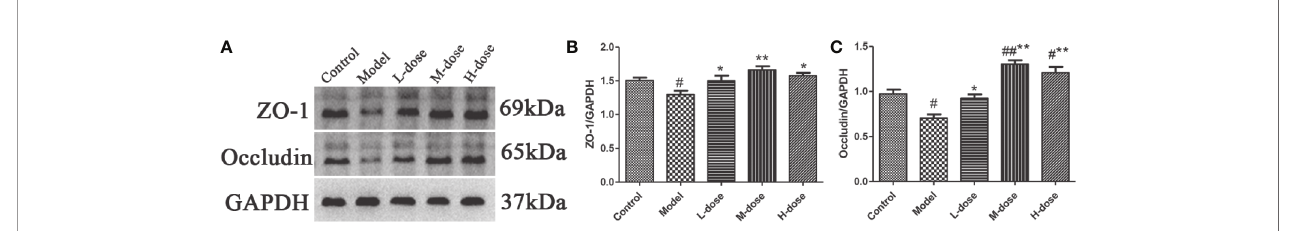
FIGURE 8 | SLBZS protects the colonic mucosal barrier integrity of mice. (A – C) ZO ‐ 1 and occludin expression levels in the colon were analyzed by western blotting. The data are shown as the mean ± S.E.M. # P < 0.05, ## P < 0.01 vs. the control group; * P < 0.05, ** P < 0.01 vs. the model group.